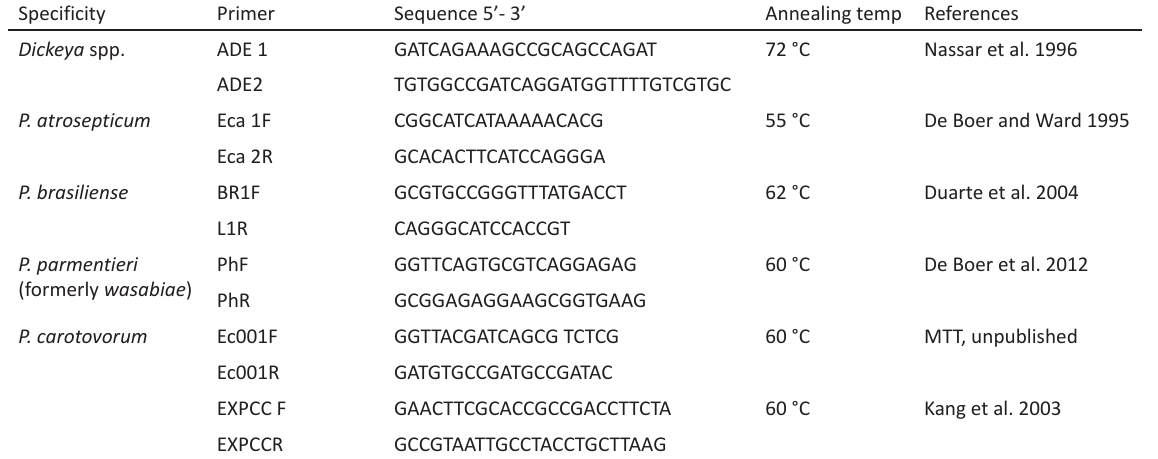
Table 1. Primers used in endpoint PCR